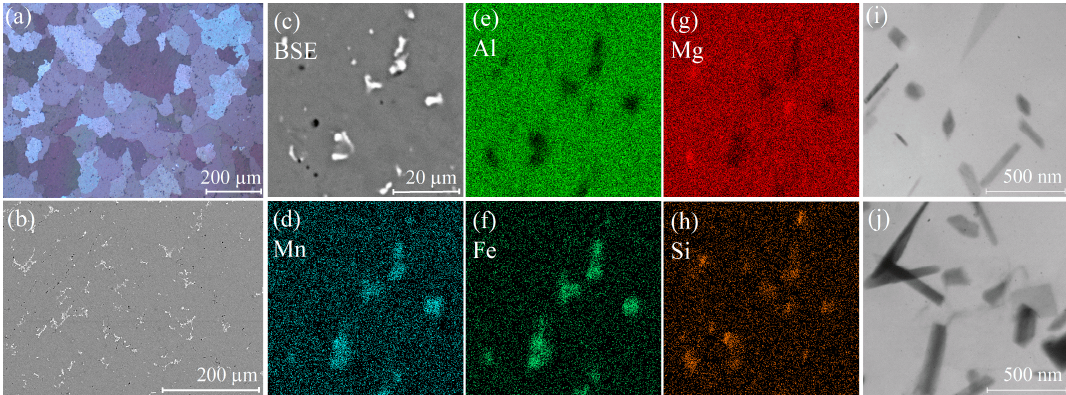
Figure 2. Microstructure after homogenization annealing (the initial state): ( a ) grain structure (light microscopy), ( b , c ) crystallization origin phases distribution, and ( d – h ) elements distribution maps of the ( c ) area (scanning-electron microscopy), and ( i , j ) transmission electron microscopy images of Mn-rich precipitates.